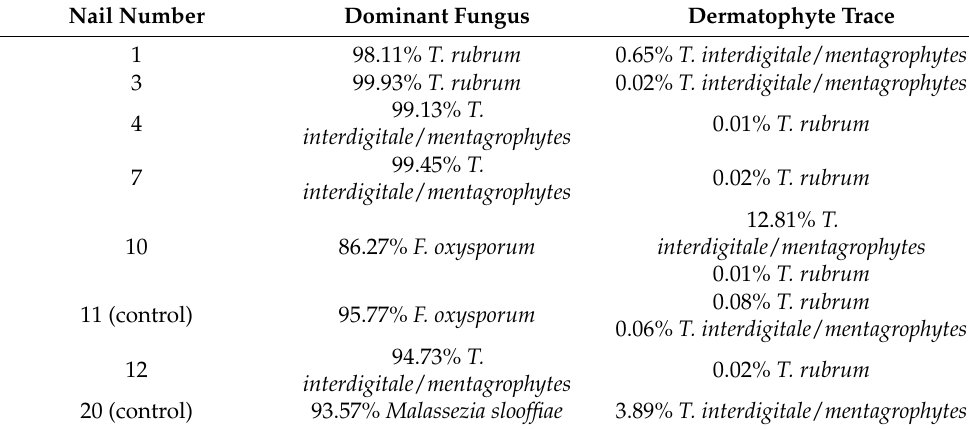
Table 1. Nails with Trichophyton species present as non-dominant